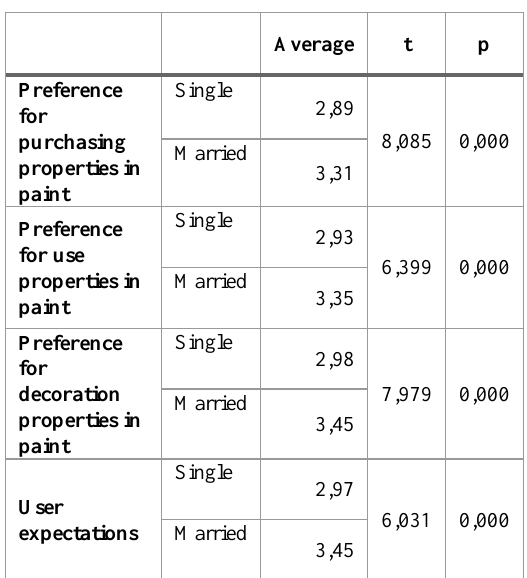
Table 18: t-test on Consumers' Preferences for Paint by Marital